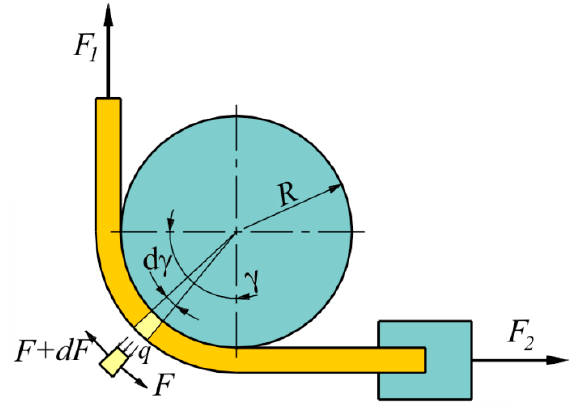
Figure 1. Forces acting on an elementary section of the strip .